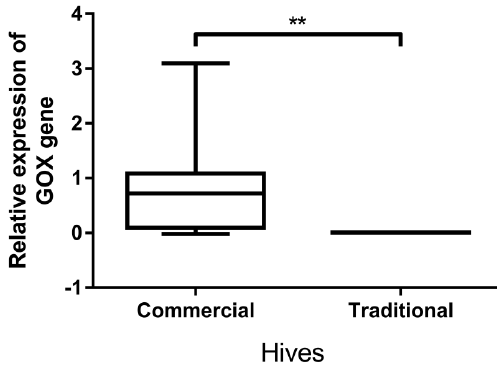
Figure 5. Glucose oxidase (GOX) gene expression levels: comparison between bees originating from commercial hives vs. trmka hives. ** Significant at p < 0.01 level .